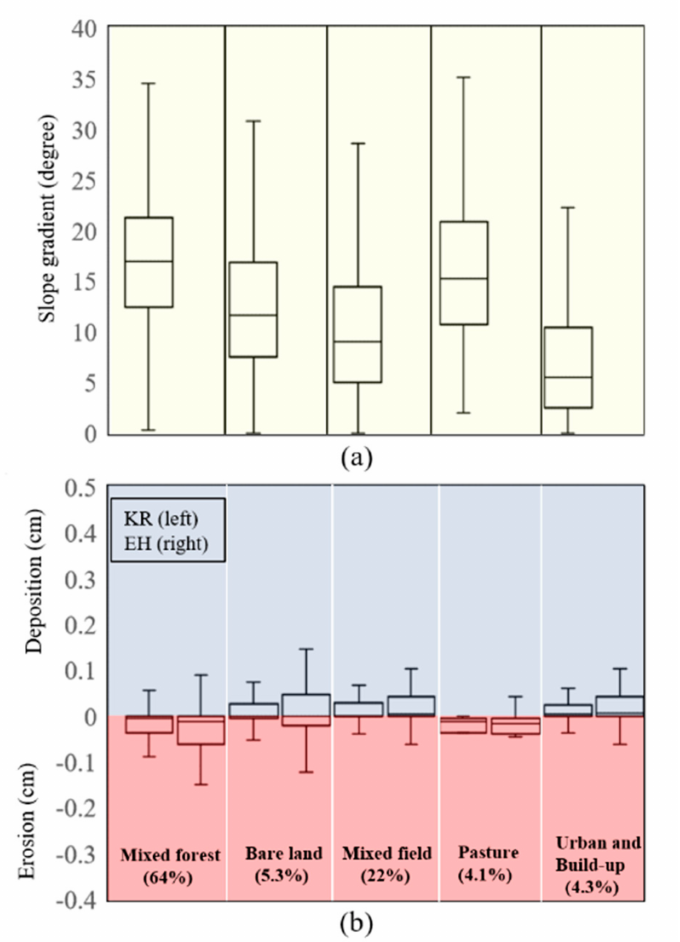
Figure 9. The interrelation between slope gradient ( a ) and land-use type ( b ) toward soil ero- sion/deposition in three events is demonstrated by